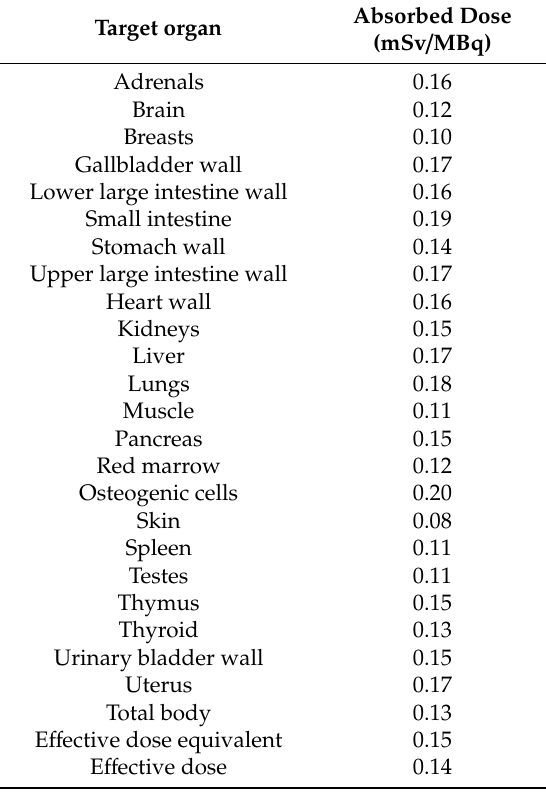
Table 3. Estimated absorbed doses of 111 In-labeled anti-CD73 antibody 063-213 in major organs and tissues in a human adult male based on biodistribution in